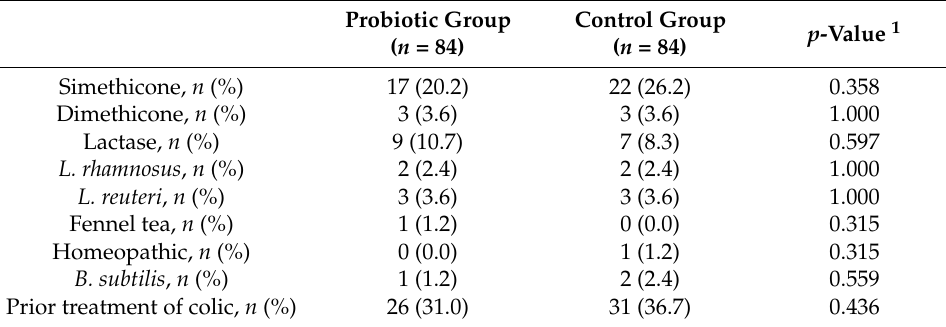
Table 3. Prior treatment of colic.